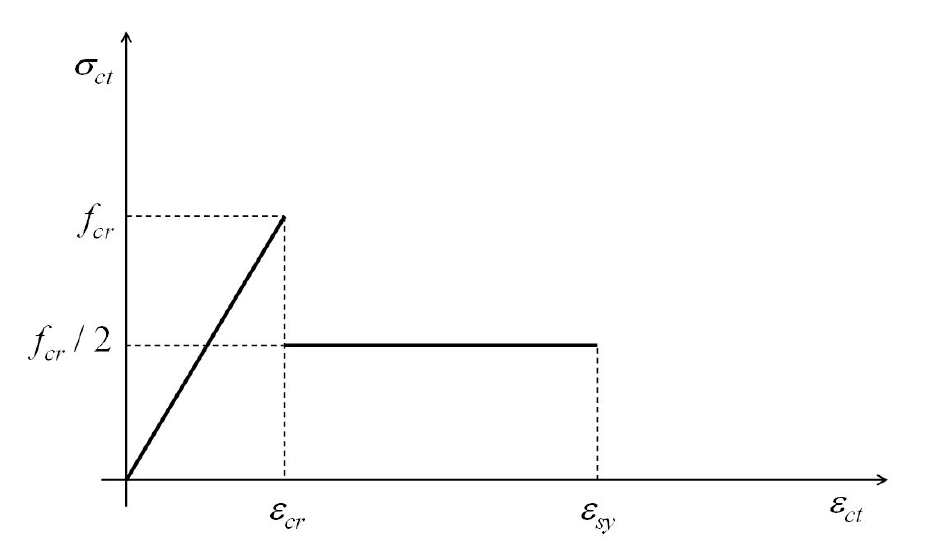
Figure 8. Constitutive model for tension in concrete with tension-stiffening